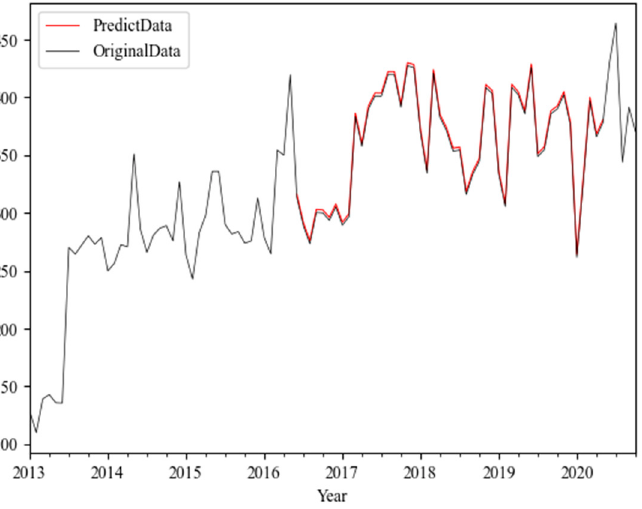
Figure 8. Fit diagram of the original value and predicted value of attention to “AI + education” in Guizhou province in a period.